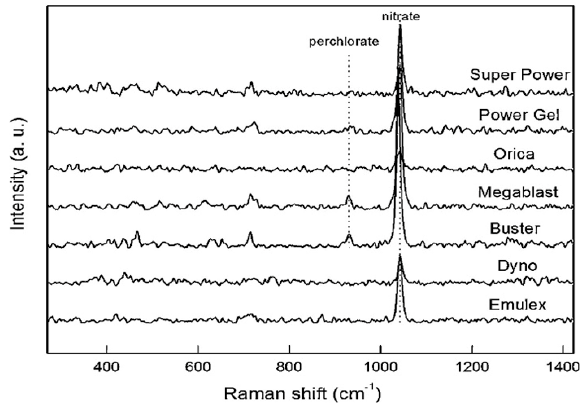
Figure 12. Raman spectra of the bulk volume of seven explosives. Adapted from [116], with permission from © 2013 Elsevier.